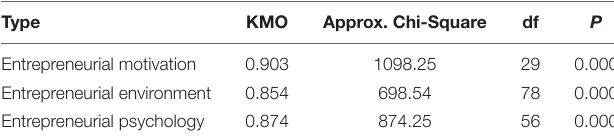
TABLE 1 | KMO and Bartlett sphere test results of three scales.